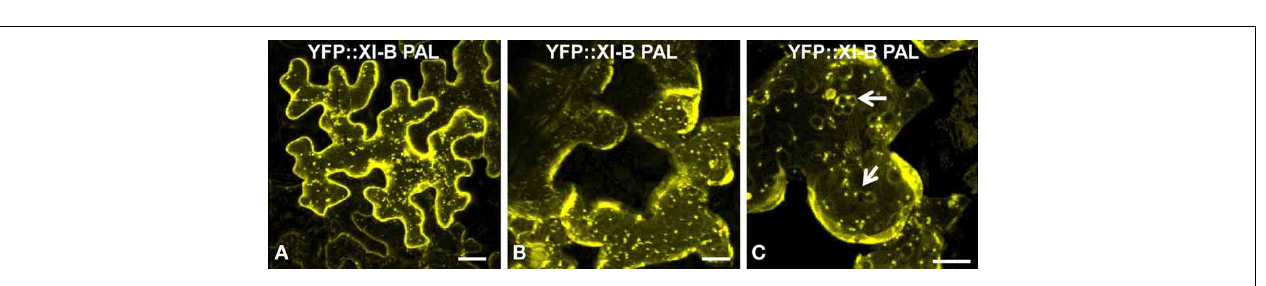
FIGURE 7 | Transient expression of YFP::At XI-B PAL in epidermal leaf cells of N. benthamiana . (A) In most cells, this YFP pattern was observed. (B and C ) Occasionally, structures